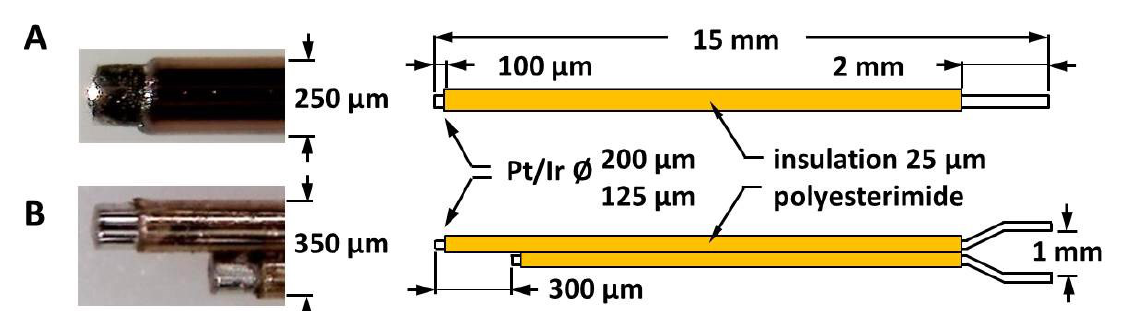
Figure 1: Photographs of tips (left) and schematic drawings (right) of (A) a unipolar electrode (200 µm wire diameter) and (B) a bipolar electrode (125 µm wire diameter). The electrode shafts were insulated with 25 µm polyesterimide. All electrode tips were bared for 100